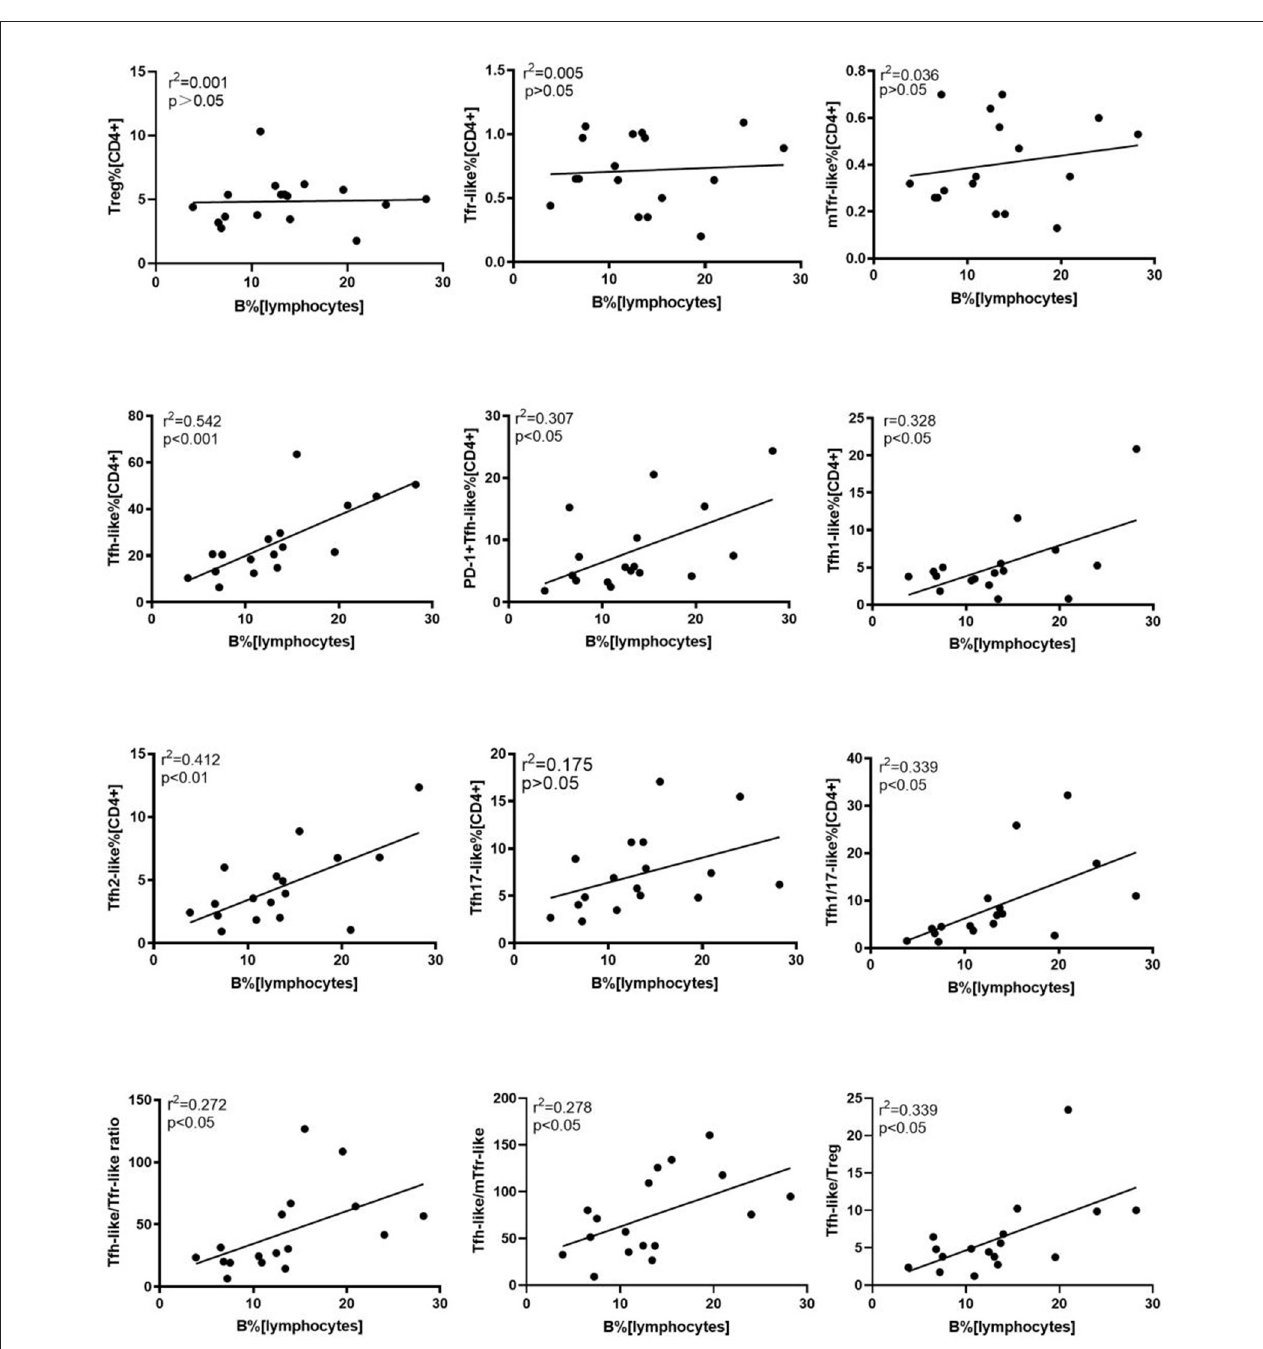
FIGURE 4 | Correlation analysis of cell subsets, cell ratios, and B cells. Correlations were assessed using Spearman’s rank test. p < 0.05 was taken to indicate statistical significance. A total of 10,000 Tfh-like cells were collected. Tfr-like, T follicular regulatory-like; mTfr-like, memory T follicular regulatory-like; Tfh-like, T follicular helper-like; Treg, T